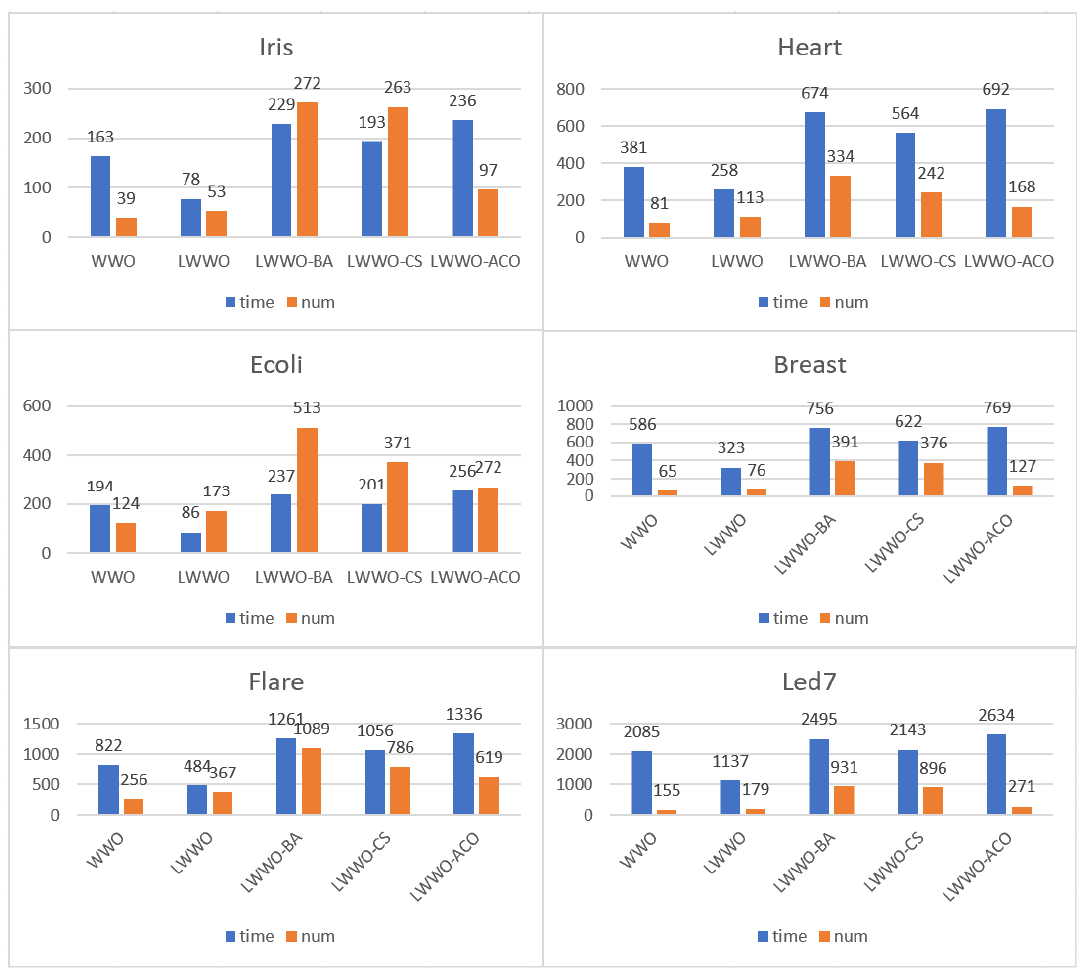
Figure 6. Comparison of average execution time and the number of rules mined.